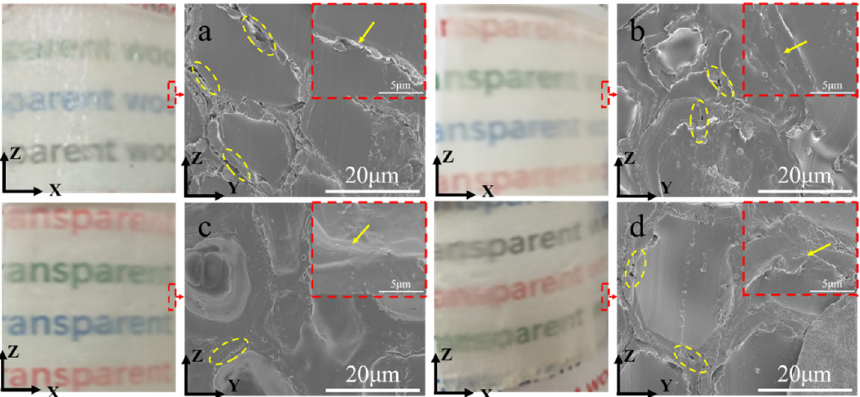
Figure 3. Microstructure of TDPV and TADPV-1, -3, and -5, named ( a – d ) respectively.